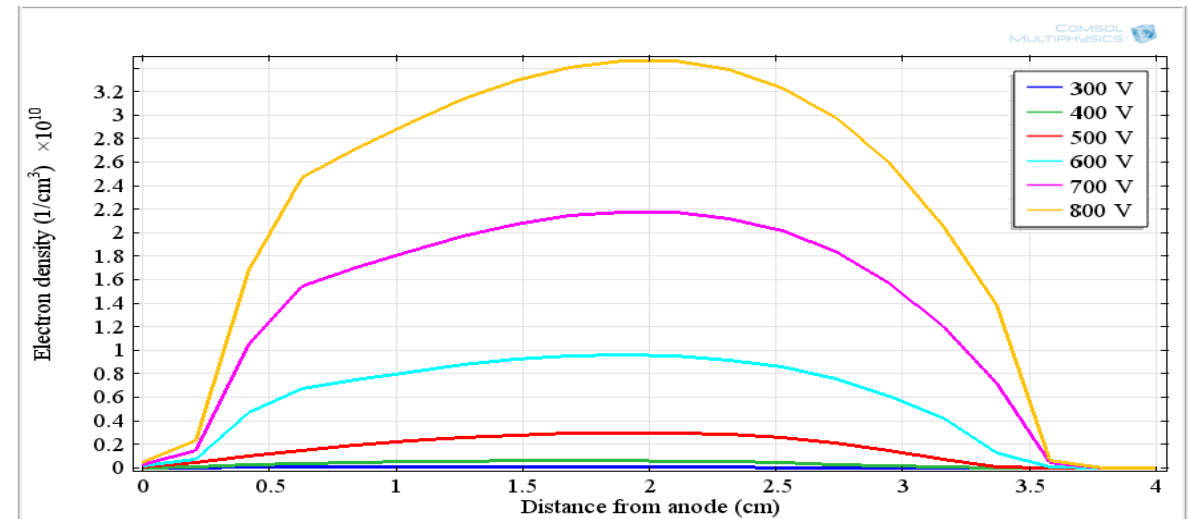
Fig. 6: Spatial profiles of electron density as a function distance from anode at different discharge voltages.